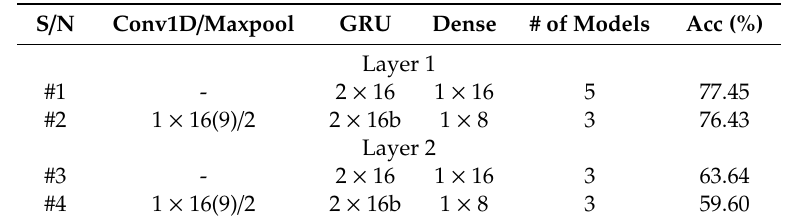
Table 5. Ensembles validation